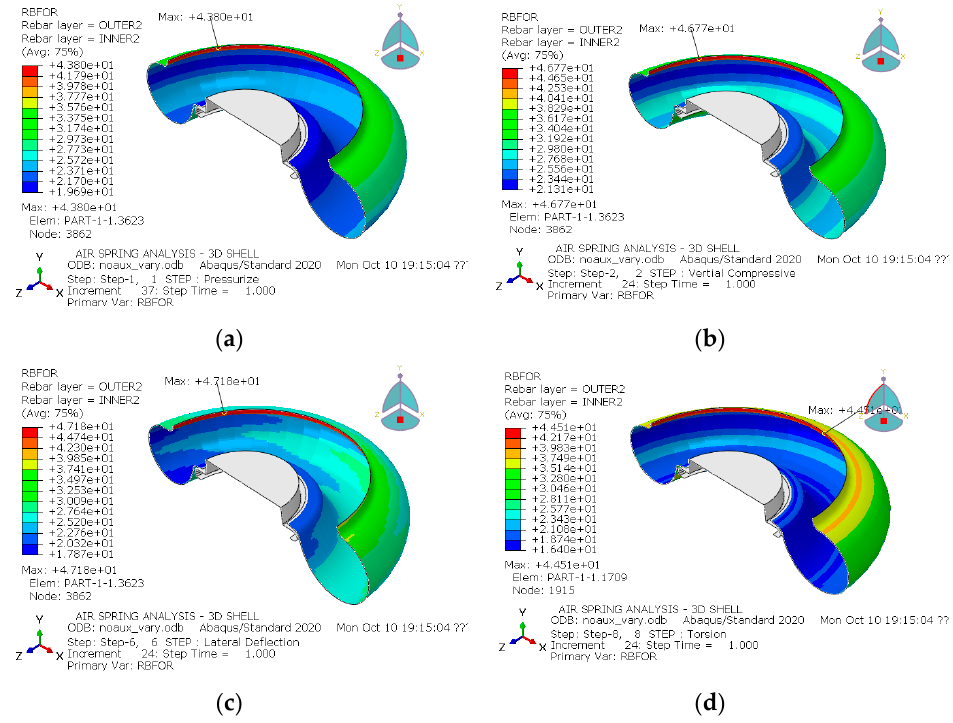
Figure 12. Distribution of rebar force (RBFOR) during analysis at variable ply angle distributions: ( a ) inflation; ( b ) vertical compression; ( c ) lateral deflection; ( d ) torsional rotation.